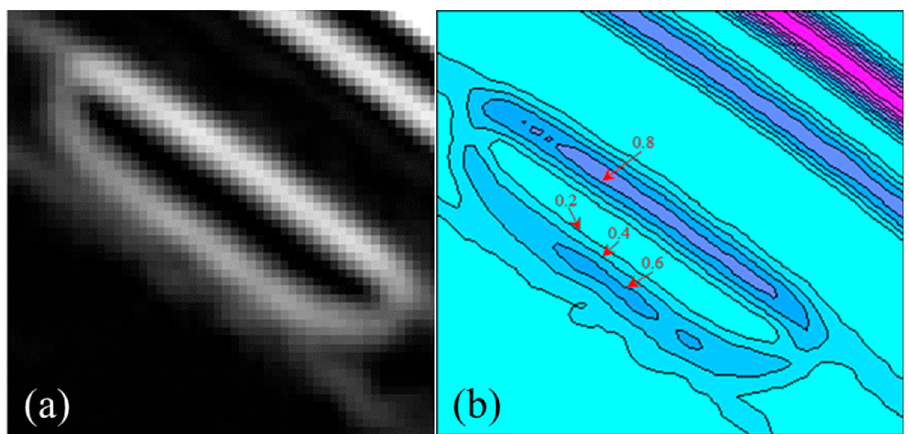
Figure 3. Contour image of type I edge gray level distribution. ( a ) The type I edge detection result of bubbles; ( b ) The contour image of bubble gray level distribution.